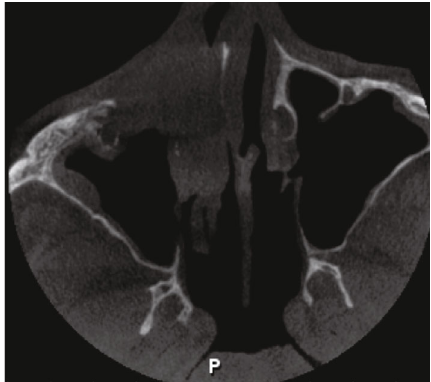
Figure 9: Axial view of CBCT scan revealing narrowing and involvement of eustachian tube on the right side.